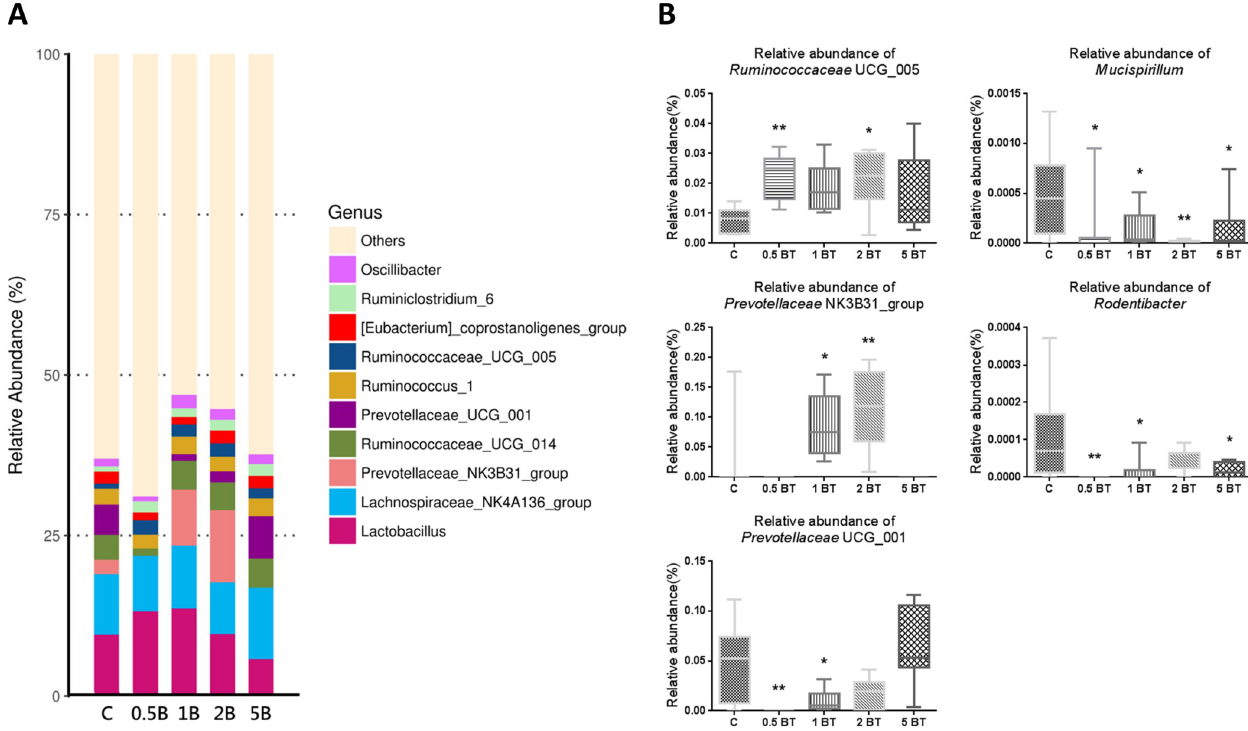
Fig 6. Variations of gut microbiota after BT treatment at genus level. (A) Effects of drinking BT on the relative abundance of the top 10 most abundant flora of gut microbiota at genus level. Bacteria represented by different colors are marked in the upper right of Fig 6A. (B) Drinking BT increased the relative abundance of Ruminococcaceae UCG_005 and Prevotellaceae NK3B31_group, whereas decreased the relative abundance of Prevotellaceae UCG_001, Mucispirillum , and Rodentibacter (n = 8). C, control; 0.5B, 0.5BT; 1B, 1BT; 2B, 2BT; 5B, 5BT. Data of relative abundance are depicted in box and whisker plots and are analyzed by one-way ANOVA. � P < 0.05; �� P < 0.01.